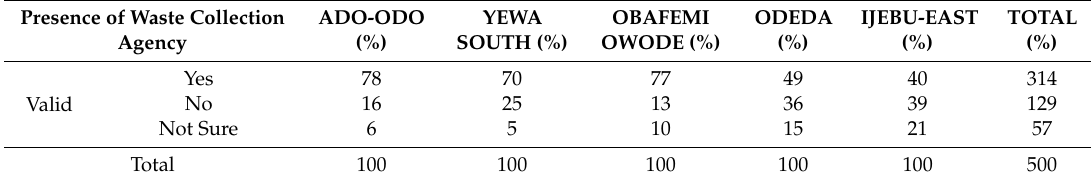
Table 6. Presence of waste collection